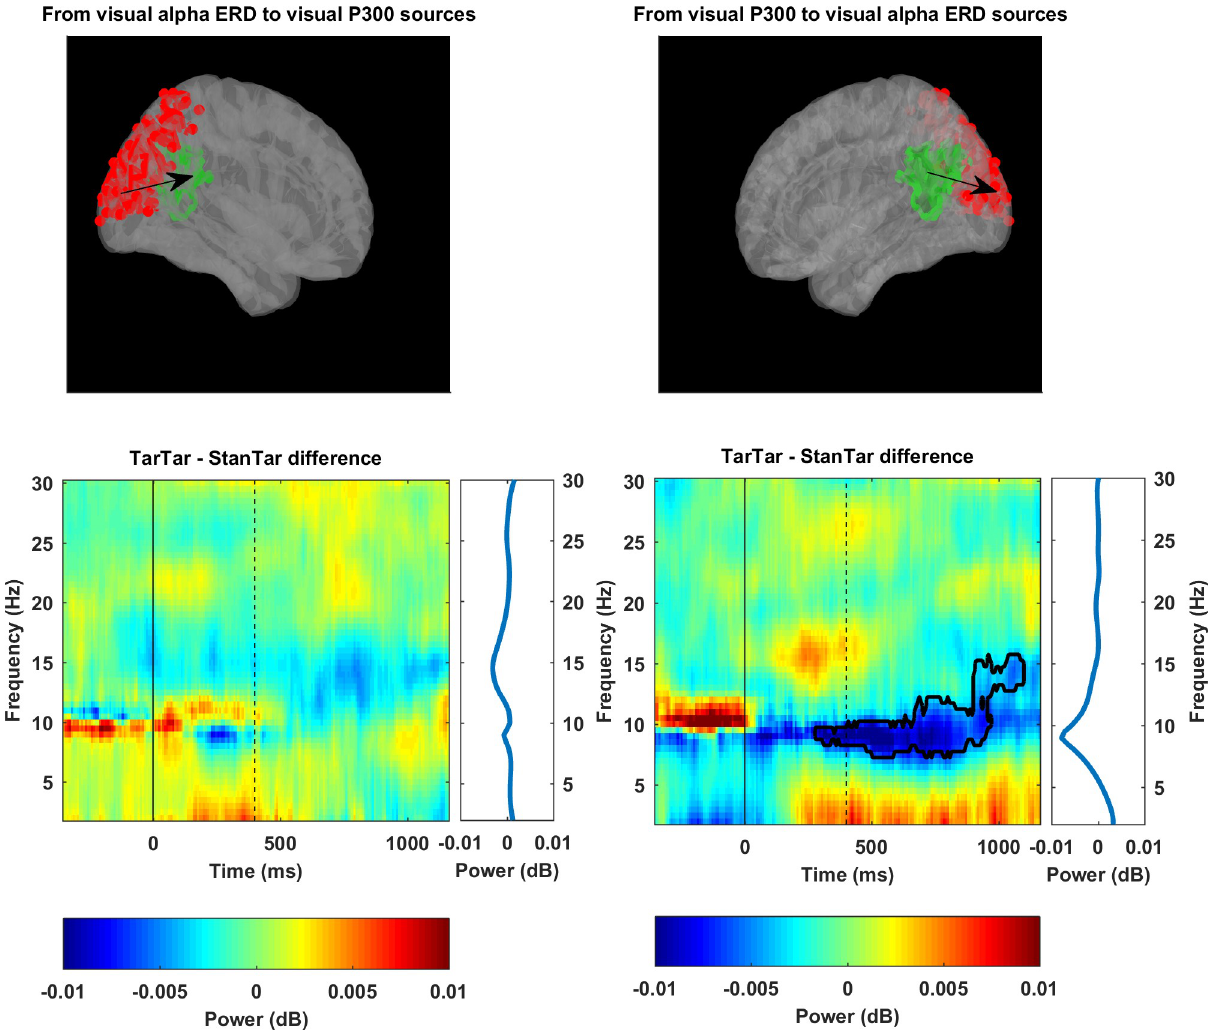
Fig 7. Regions of interest and time-frequency maps of effective connectivity power difference between target-target and standard-target conditions. The upper row shows left and right views of the same cortex template containing the ROIs from which brain waves were extracted and effective connectivity was computed. ROI marked by green refers to visual P300 sources. ROI marked in red refers to the first 10 percent of voxels with the highest activation values specified as visual alpha ERD sources. The left time-frequency map on the bottom row indicates no significant spectral power density difference in the flow of information from visual alpha ERD sources to visual P300 sources across conditions. However, the highlighted time-frequency area in the right image on the bottom row indicates significant differences in the flow of alpha power reduction from visual P300 sources to visual alpha ERD sources (p < 0.05). The subplots on the right side of time-frequency maps show spectral power density differences between two conditions (corresponding to the time-frequency maps on their left) that are averaged across the whole epoch (starting from time = 0 ms up to the end of the epoch). The spectral power density subplot of flow of information from visual P300 to visual alpha ERD sources reveals a major power reduction difference between two conditions that peaks at 9 Hz. The solid black line indicates the onset of auditory stimuli and the black dashed line shows the onset of visual stimuli. ERD, event-related desynchronization; ROI, region of interest; dB, unit of spectral power density (see Method section).